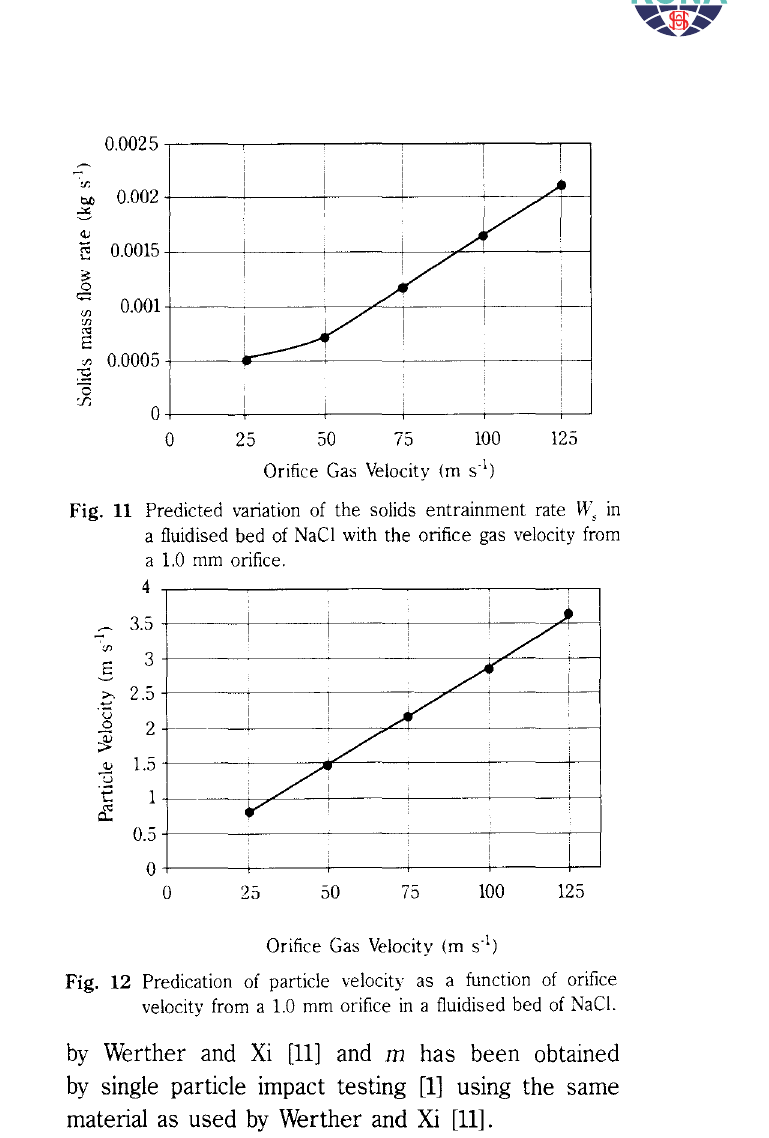
Fig. 10 Variation of the attrition per jet with jet velocity for the jetting region of a fluidised bed containing PDV salt. calculatd at a jet height estimated from the Yang and Keaims [31] correlation. Table 3. Fluidised bed hydrodynamic and attrition power indices Parameter